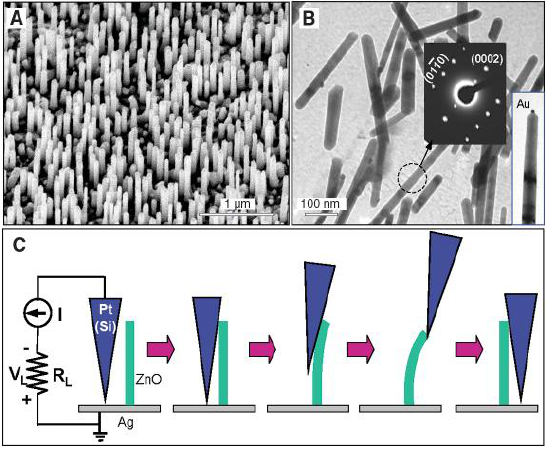
Figure 9. Nanowire array based generator presented by Wang and Song from [35] (Reprinted with permission from AAAS).